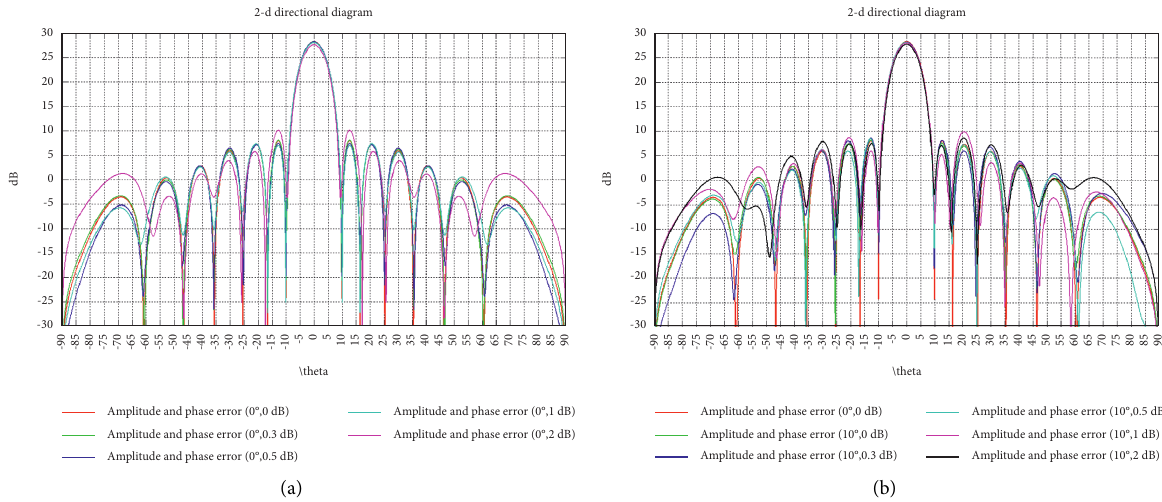
Figure 3: Simulation results of random amplitude and phase antenna without scanning pattern: (a) phase is 0 ° ; (b) phase is 10 °